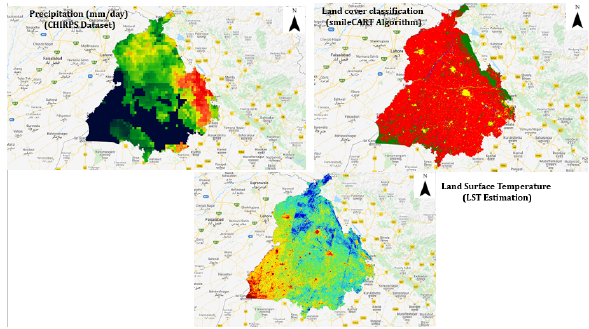
Figure 3: LST, Land Cover Classified Image, Precipitation (mm/hr)